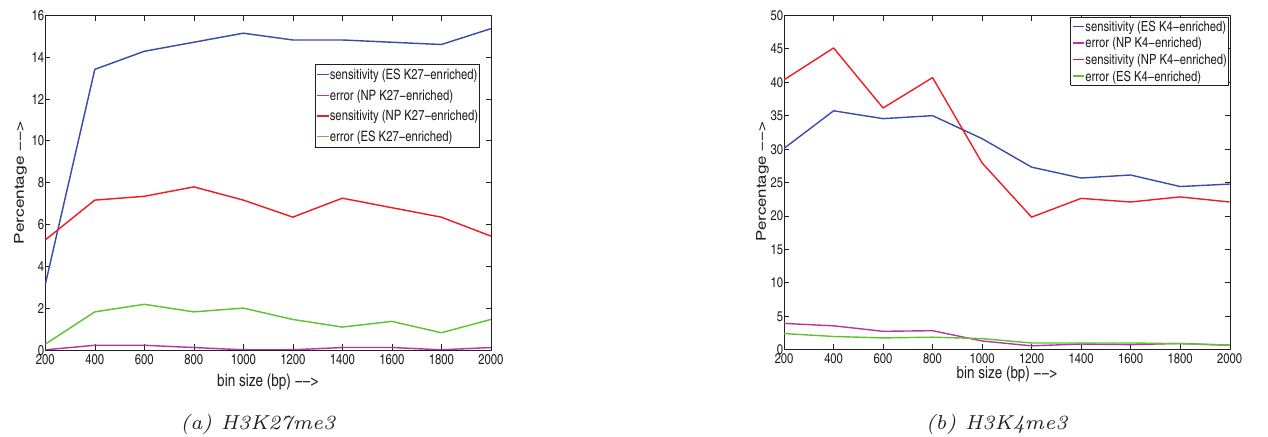
Figure 8. Robustness studies: sensitivity and error analysis for ChIPnorm by fixing the fold-change threshold t ~ 3 and varying the bin size from 200 bp to 2000 bp in steps of 200 bp. Data from Mikkelsen et al. 2007 [8].